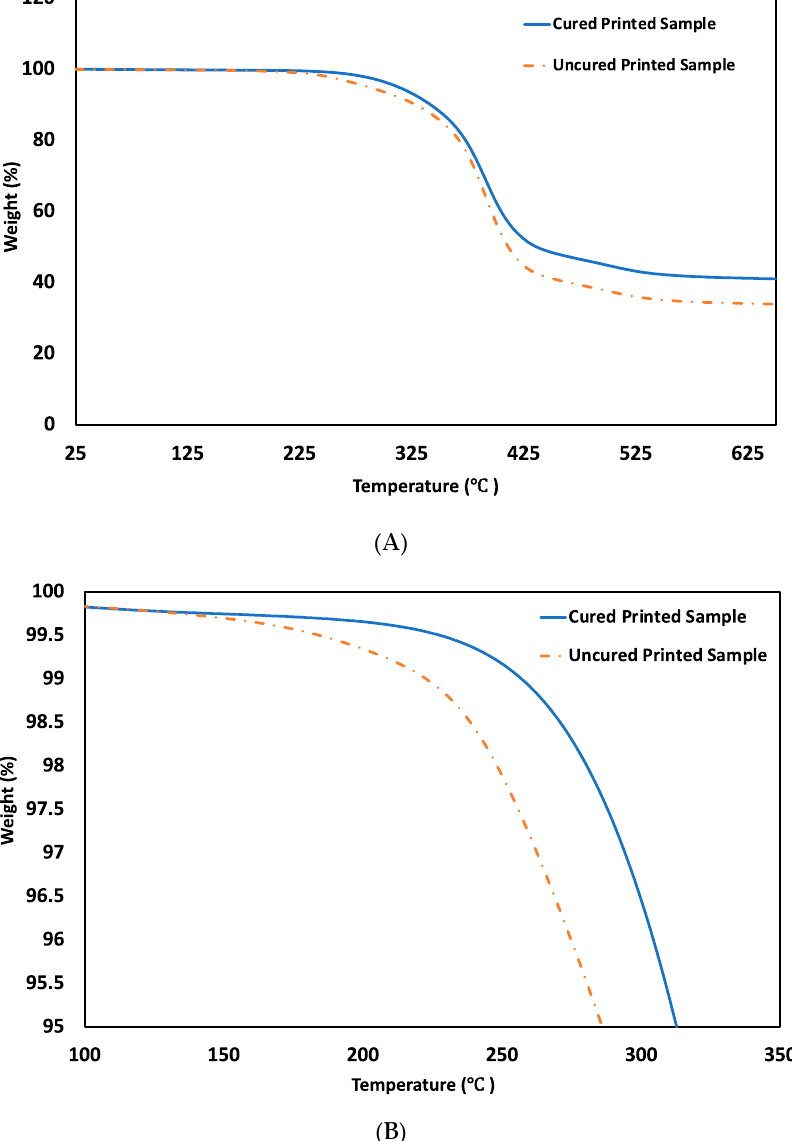
Figure 2. Thermogravimetric Analysis (TGA) of epoxy thermoset sample ( A ) weight loss thermogram and ( B ) 1% to 5% weight loss in thermogram. and ( B ) 1% to 5% weight loss in